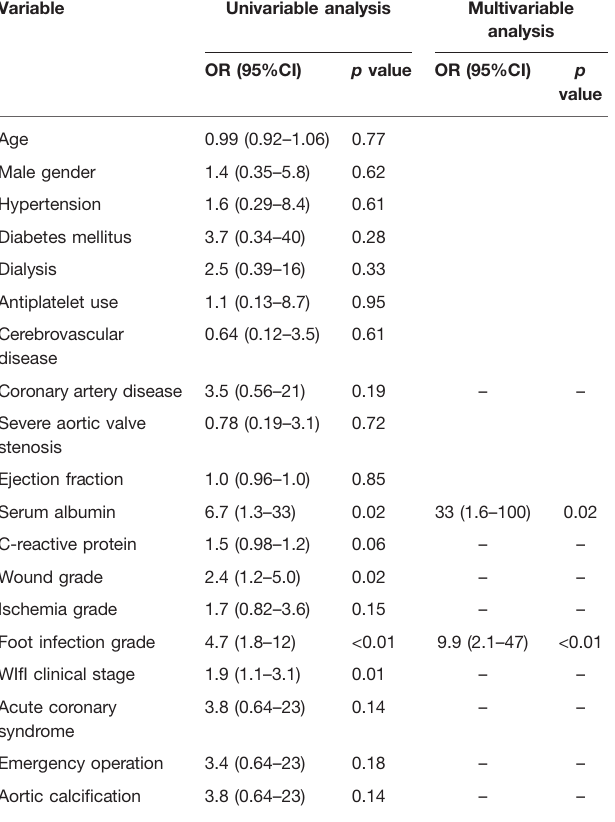
TABLE 3 | Risk factors of major complications during hospitalization.